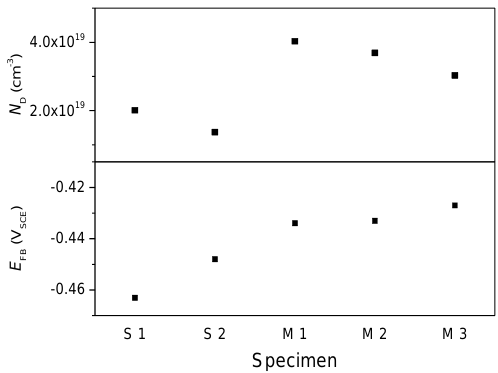
Figure 10. Donor density and flat band potential determined by Mott–Schottky analysis.